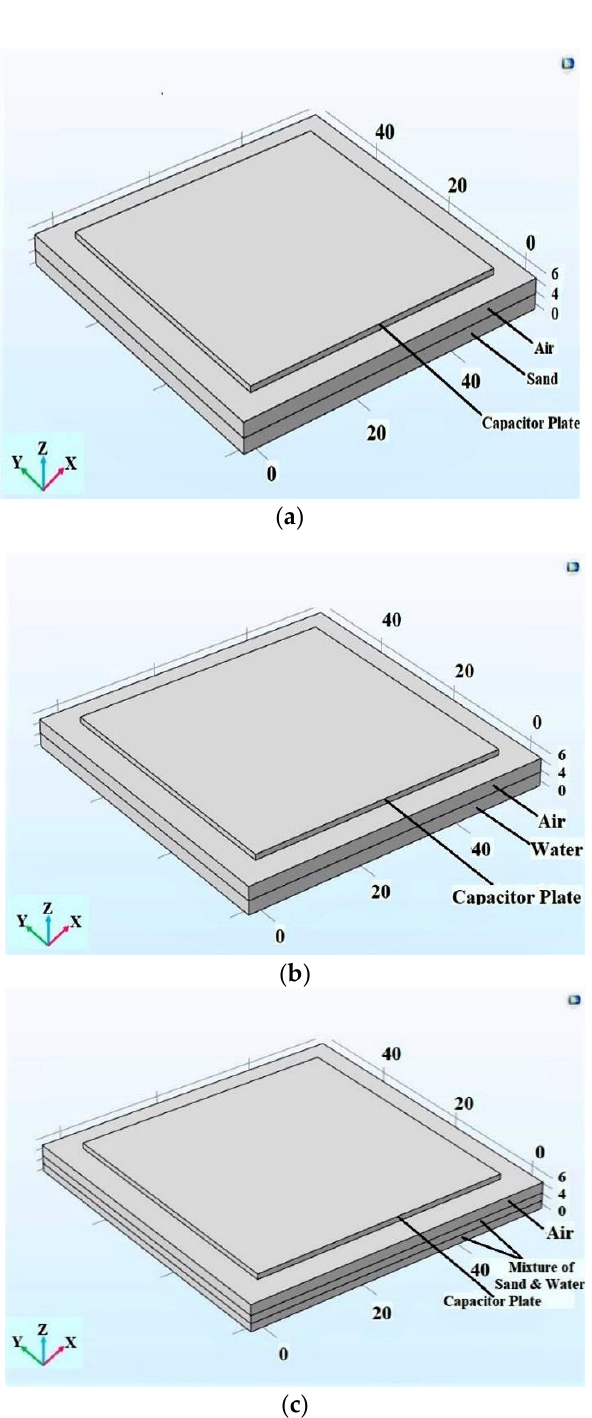
Figure 25. Variation of capacitance with respect to material thickness.